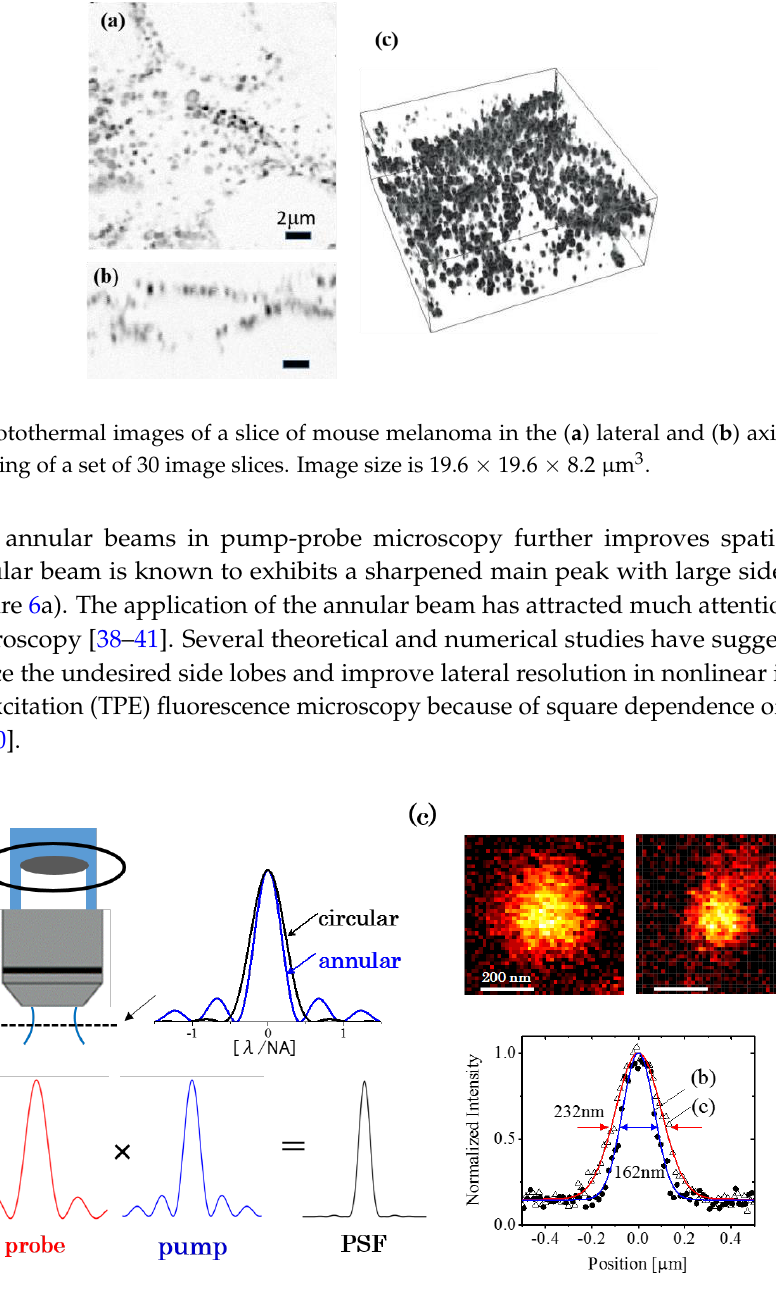
Figure 6. Improvement in the spatial resolution with the annular beams: ( a ) Intensity profiles of the annular and circular beams at the focal. An annular pupil filter was used to produce the annular beams; ( b ) Point spread function in pump-probe microscopy with the annular beams; ( c ) Photothermal images of 20 nm gold nanoparticles with the ( left ) circular and ( right ) annular beams. ( c ) Single particle images with the circular ( left ) and annular ( right ) beams, respectively. Their intensity profiles in the transverse direction ( bottom ). A 488-nm LD and a 640-nm LD were used for the pump and probe beams. The numerical aperture of the objective lens is 0.95.